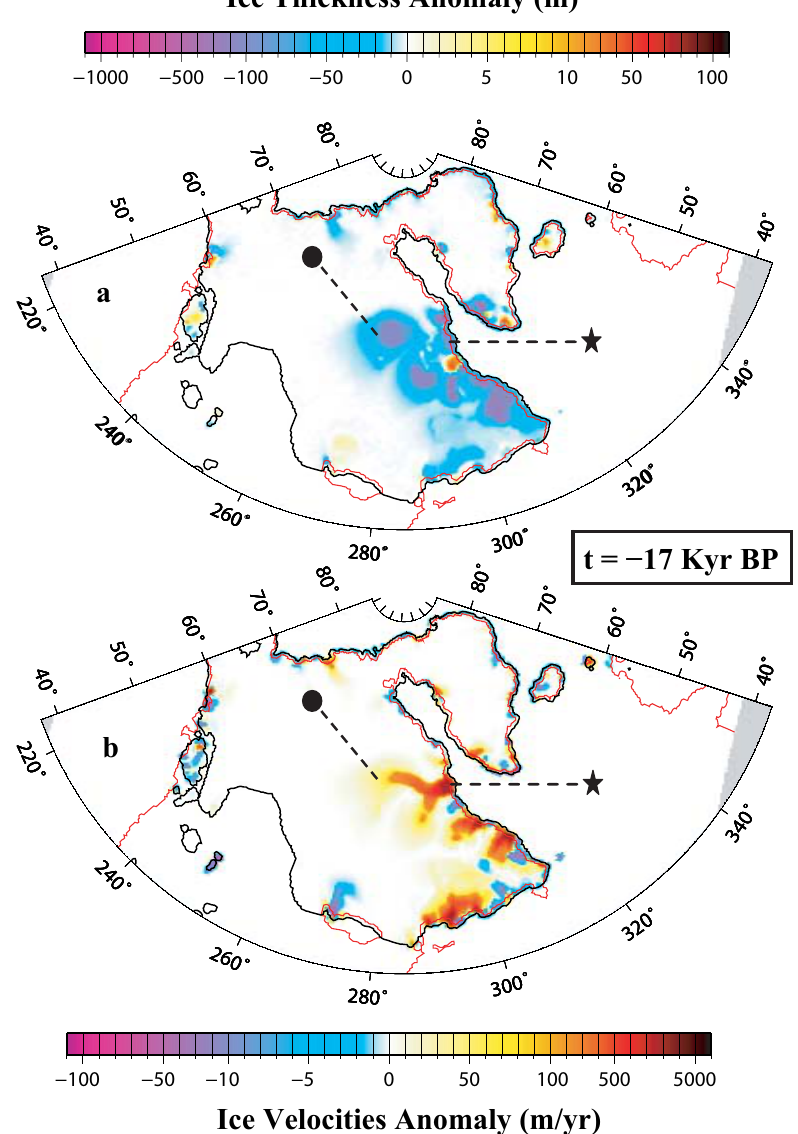
Fig. 2. Ice thickness (in m) and velocity (in myr − 1 ) anomalies of the Greenland and Laurentide ice sheets when accounting for the effects of the oceanic circulation changes (implying an oceanic subsurface warming) after one thousand years at 17kaBP. The star and circle indicate the location of the Hudson Strait ice stream mouth and source,